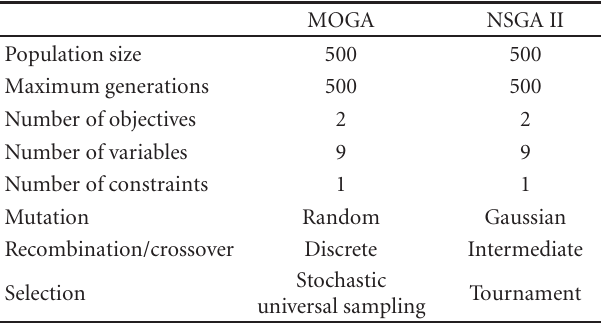
Table 2: MOGA and NSGA II specifications for the stand-level op- timal thinning regime problem for E. fastigata